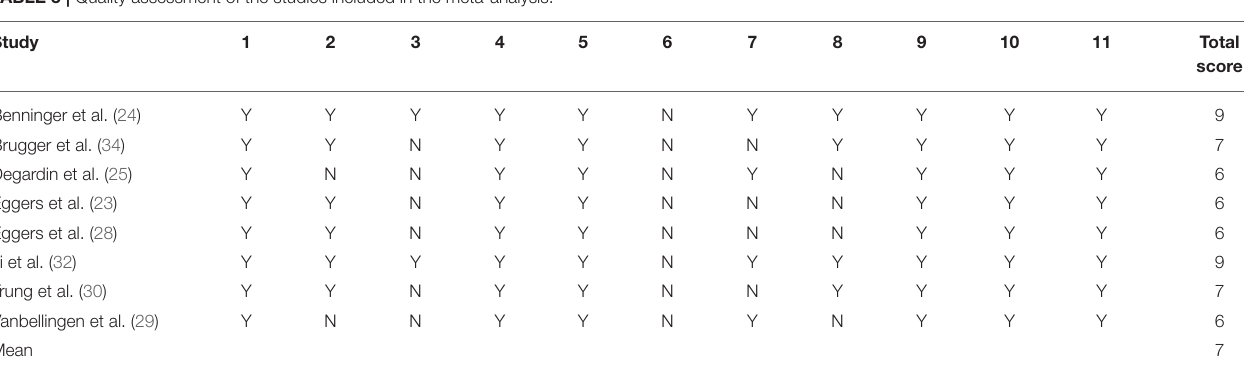
TABLE 3 | Quality assessment of the studies included in the